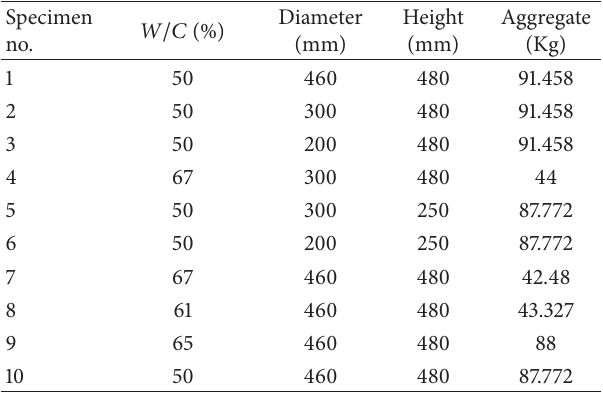
Table 1: Characteristics of experimental specimens for set 𝐼 .